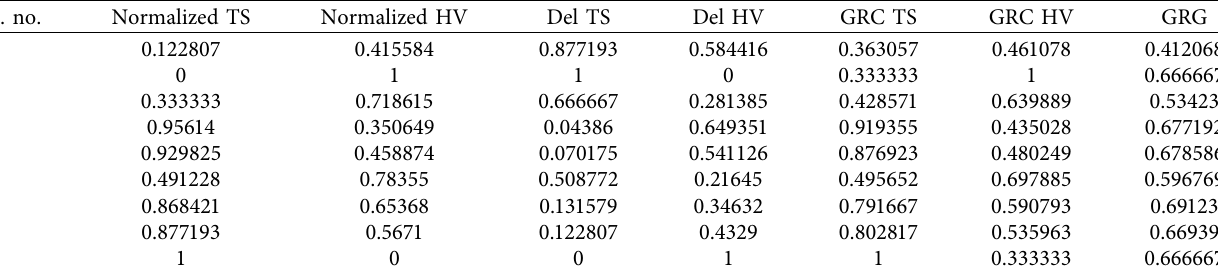
Table 3: GRG for